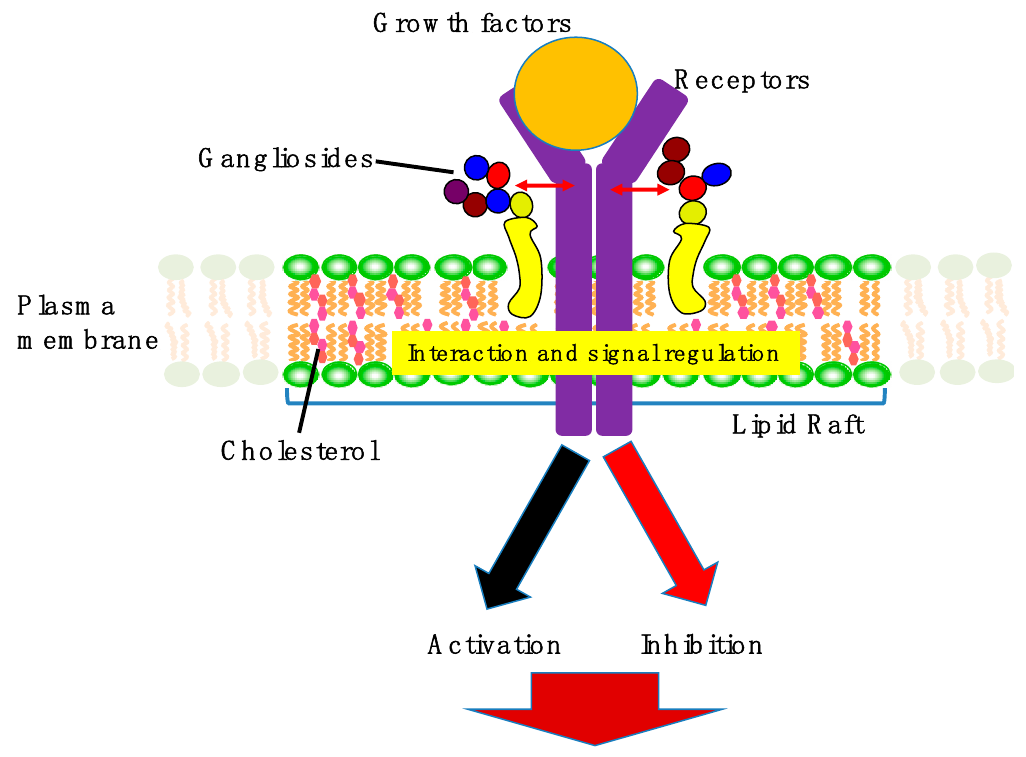
Figure 3. The effects of gangliosides on cancer cell signaling. Gangliosides usually form complexes with several types of RTK receptors in lipid rafts of cancer cells. These interactions contribute to the activation or inhibition of RTK signaling, leading to suppression or promotion of malignant properties in cancer cells. RTK, receptor tyrosine kinase.